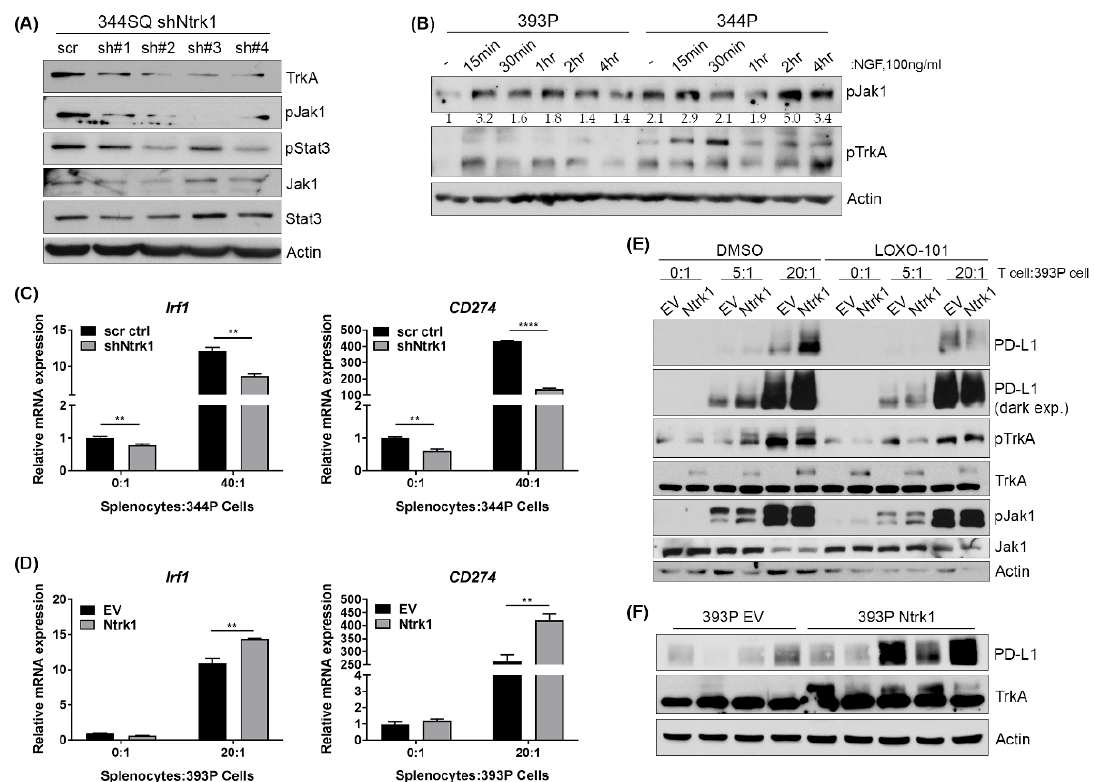
Figure 5. Ntrk1 can regulate JAK/STAT signaling to promote expression of PD-L1. ( A ) Western blot analysis of 344SQ Ntrk1 knockdown cells probing for phospho-Jak1 and phospho-Stat3. Actin was used as a loading control. ( B ) Western blot analysis of 393P and 344P cell lines stimulated with NGF at 100ng/ml over a short time course to assay activation of phospho-Jak1 and phospho-TrkA. Densitometry calculations of phospho-Jak1 intensity relative to actin were normalized to 393P (-) and are shown below the phospho-Jak1 blot. ( C ) Real-time qPCR analysis of CD274 (PD-L1) expression in 344P Ntrk1 knockdown cells when co-cultured with total splenocytes. ( D ) 393P Ntrk1 overexpression cells were co-cultured with total splenocytes and assayed using qPCR for expression of CD274. ( E ) 393P Ntrk1 overexpression cells were cultured alone (0:1) or co-cultured with total splenocytes at 5:1 and 20:1 ratios. Either DMSO control or LOXO-101, a pan Trk-inhibitor, were added to the co-culture at the time of seeding. After 3 days, tumor cells were assayed for protein expression of PD-L1, phospho-TrkA, and phospho-Jak1. ( F ) Western blot analysis of PD-L1 expression in 393P empty vector (EV) control and Ntrk1 overexpression tumors.